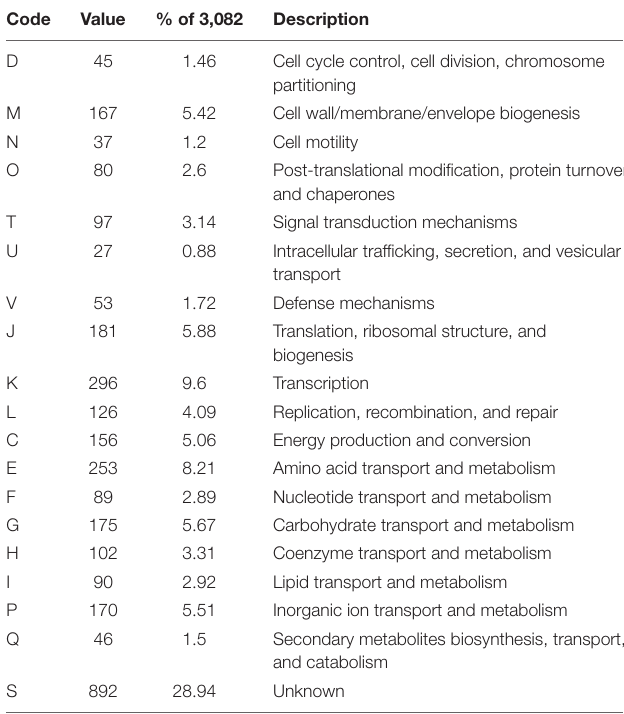
TABLE 2 | Functional annotation of orthological